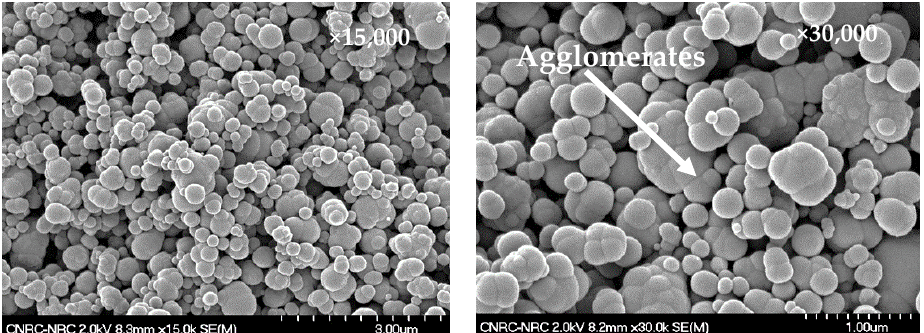
Figure 2. SEM morphology of pristine TB Thermax ® N990.